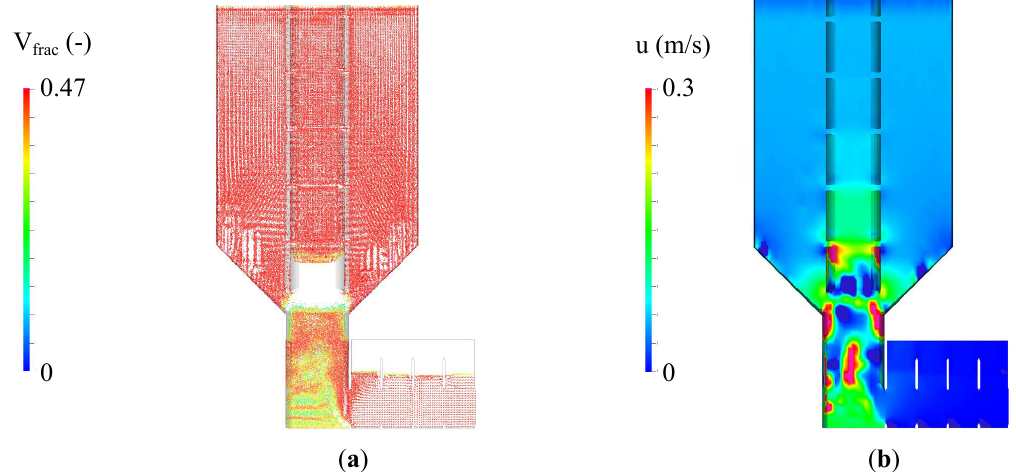
Figure 13. Pipe 2 is plugged due to rotationally symmetric frictional locking after 185 s and V frac = 1 − ψ , ( a ) unitless and ( b ) positive z-direction fluid velocity